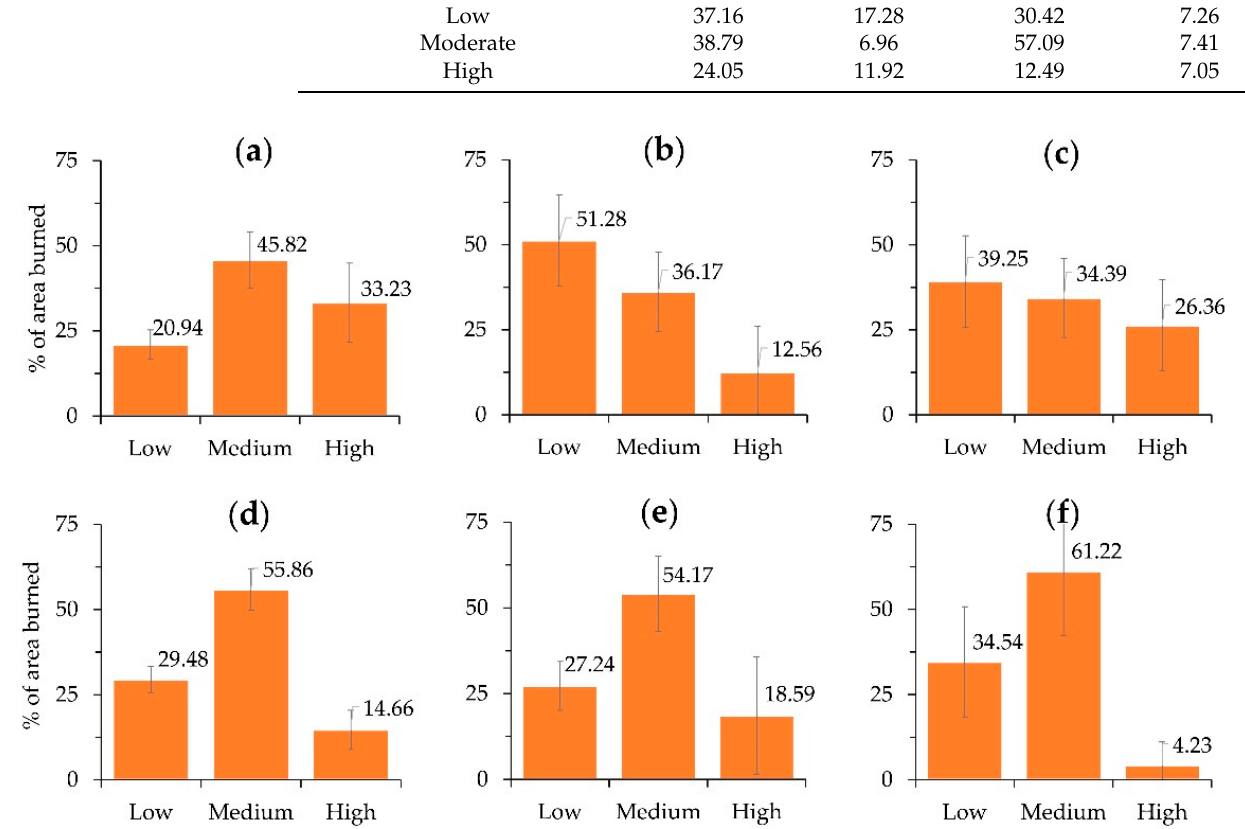
After threshold classifying of dNBR (Table 2) the proportions were evaluated for low, moderate, and high fire severity in dense tree stands (37%, 38%, and 24%, of the total areas burned, respectively) and in sparse stands and tundra vegetation dominated in the north up to ~24.1% of burned forests under the condition of close tree stands, although severe fire proportion decreases almost two times (12.5% of the area burned on average) in sparse vegetation and tundra (Table 4). The degree of fire impact varied significantly, depending on the density of forest stands and the dominant tree species (Figure 3). Table 4. The proportion (%) of fire burned (mean, and standard deviation), characterized with low, moderate, and high degree of fire impact on vegetation in comparison both for dense forest stands and for sparse and tundra. In Dense Forest Stands In Sparse and Tundra Degree of Fire Impact Mean SD Mean SD Low 37.16